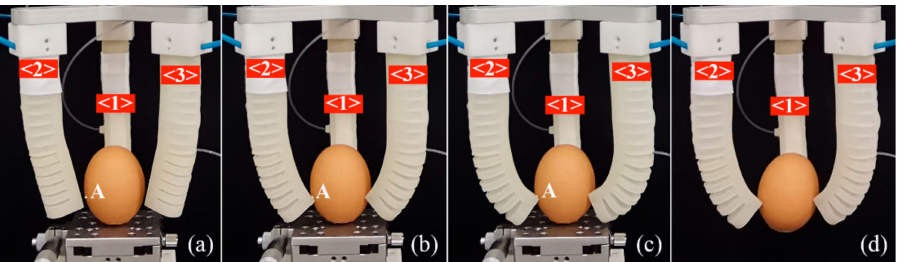
Figure 14. Grasping process of an egg: ( a ) the soft actuator approaches the egg when the pressure of pneumatic module one is 10 kPa and that of module two is zero; ( b ) the soft actuator’s tip can make contact with the egg when the pressure of module one is 20 kPa and that of module two is 14.1 kPa; ( c ) the gripper pinches the egg tightly when the pressure of module one is 20 kPa and that of module two is also 20 kPa; ( d ) the egg is grasped stably when the platform is